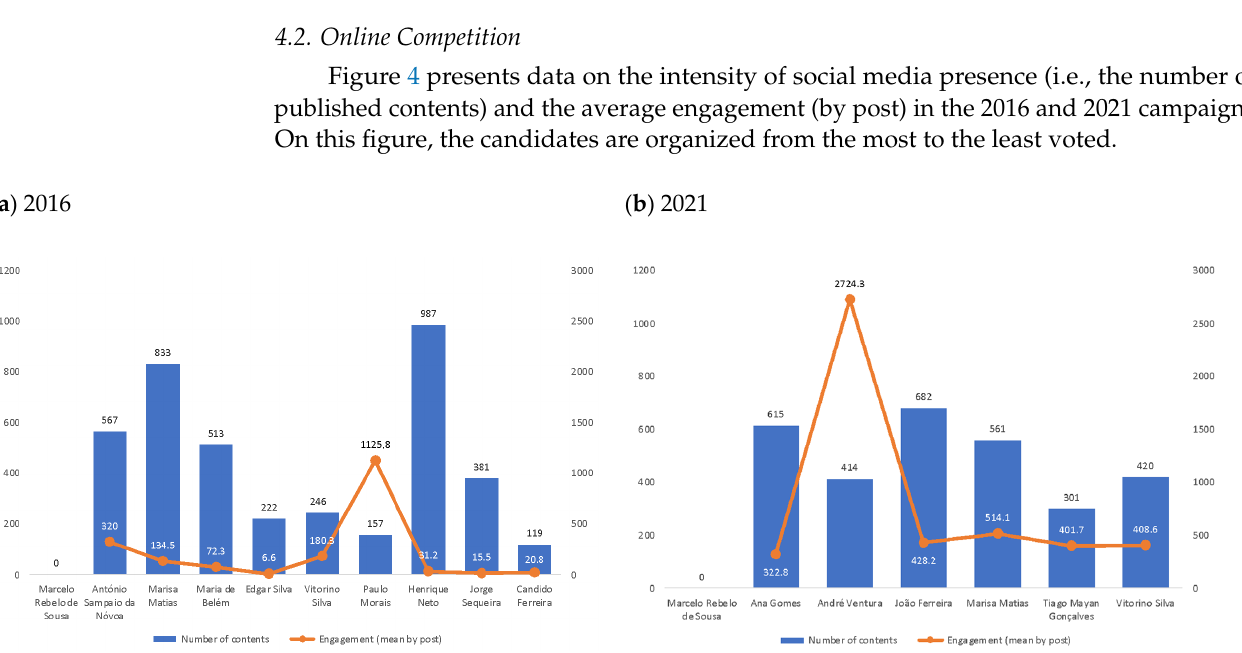
Figure 3. Traditional vs. Digital Campaigning. Comparison between the periods before and after the declaration of lockdown (2021). Source: Own data (see Section 3.1.1).